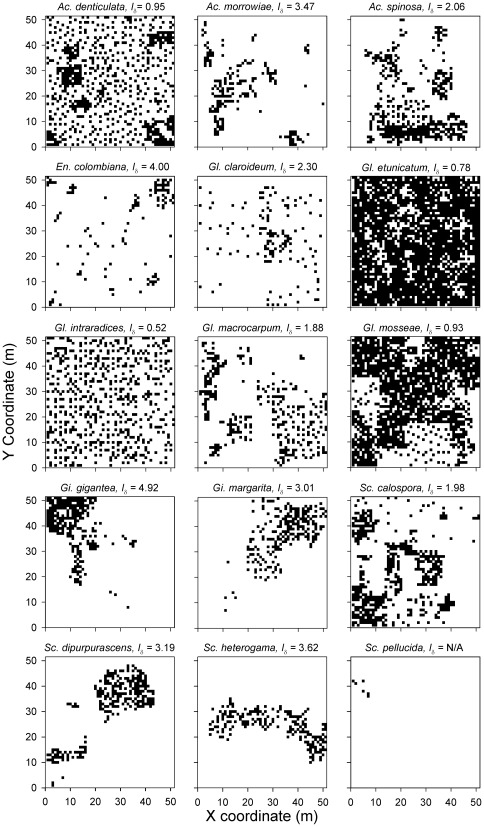
The distribution of each species across the 50 m×50 m sampling grid.Species were scored as present or absent in each of the 2601 sampled communities.